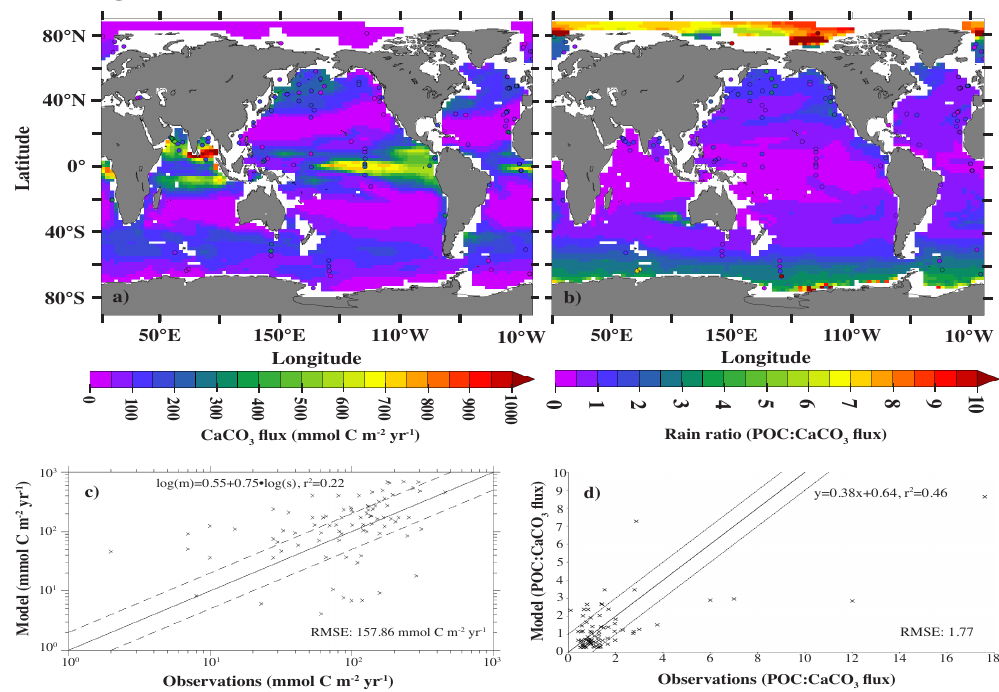
Fig. 21. The simulated fluxes of (a) PIC and the (b) rain ratios at 2km. Observed PIC fluxes and rain ratios (Honjo et al., 2008) are plotted as filled circles. Statistical comparisons with the observations are shown in (c) and (d)